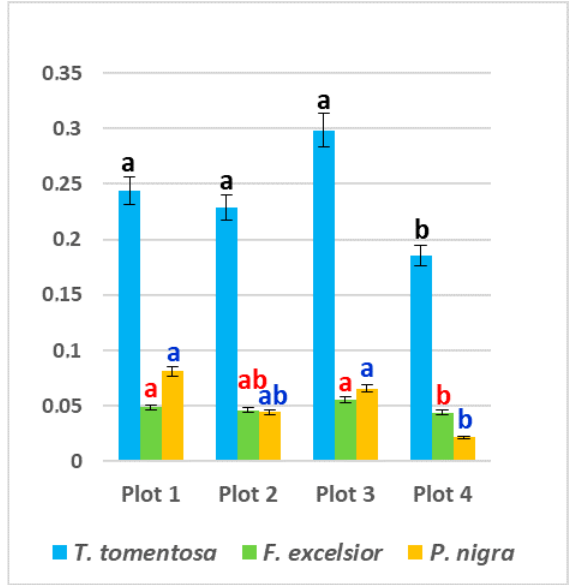
Figure 4. Content of free proline (mg g − 1 fw) in leaves of studied tree species, planted in four urban plots with different types and intensity of anthropogenic impact. For each tree species ( Tilia tomentosa in black, Fraxinus excelsior in red; Pinus nigra in blue), means showing different letters are significantly different according to Student’s LSD comparison test ( p < 0.05).